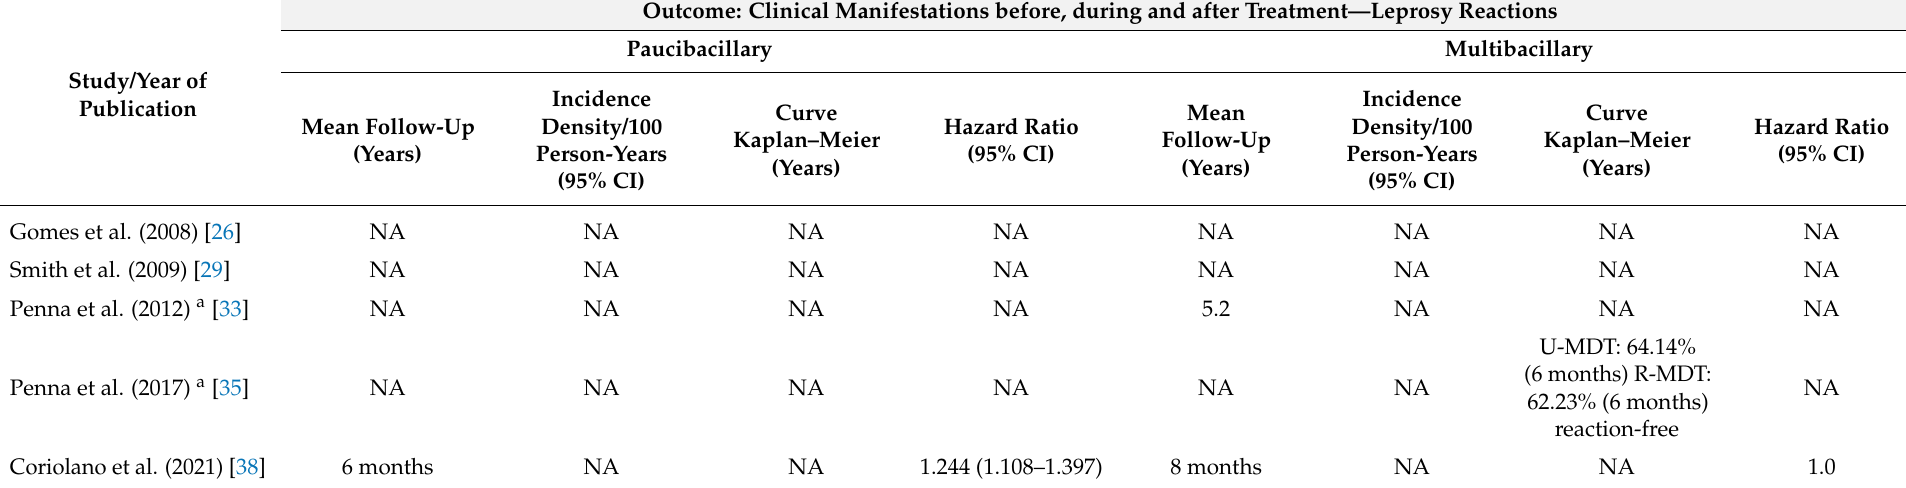
Table 4. Reporting survival analyses of the included studies by outcome clinical manifestations before, during and after treatment—leprosy